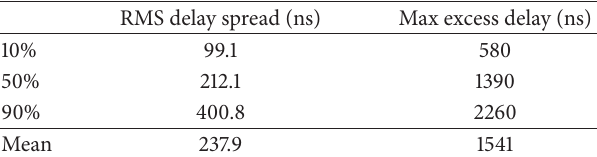
Table 2: The delay spread statistics in HSR hilly terrain.